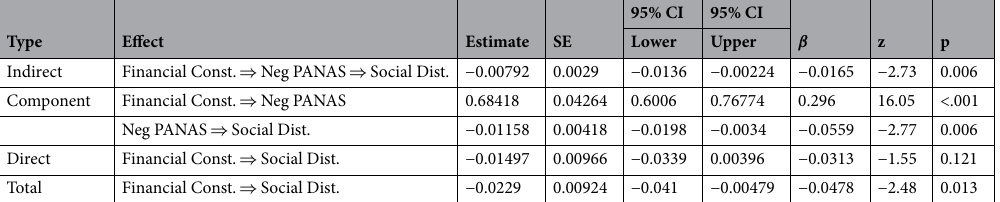
Table 7. Indirect and total effects for social distancing mediation model. Confidence intervals computed with method: Standard (Delta method). Betas are completely standardized effect